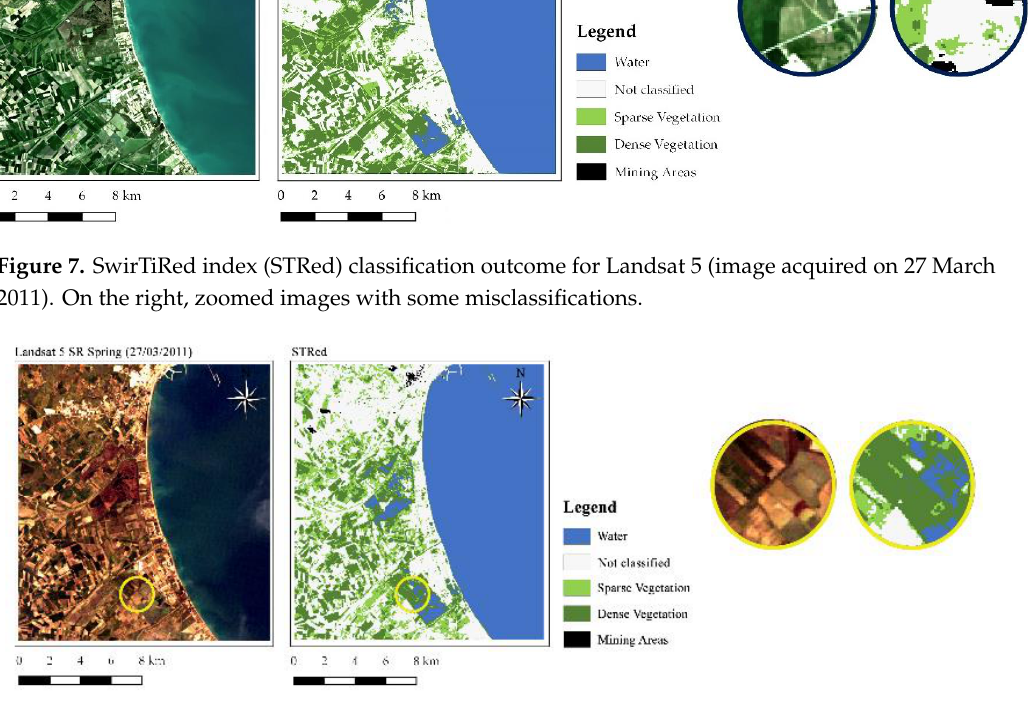
Figure 8. SwirTiRed index (STRed) classification outcome for Landsat 5 (image acquired on 5 October 2011). On the right, zoomed images with some misclassifications.